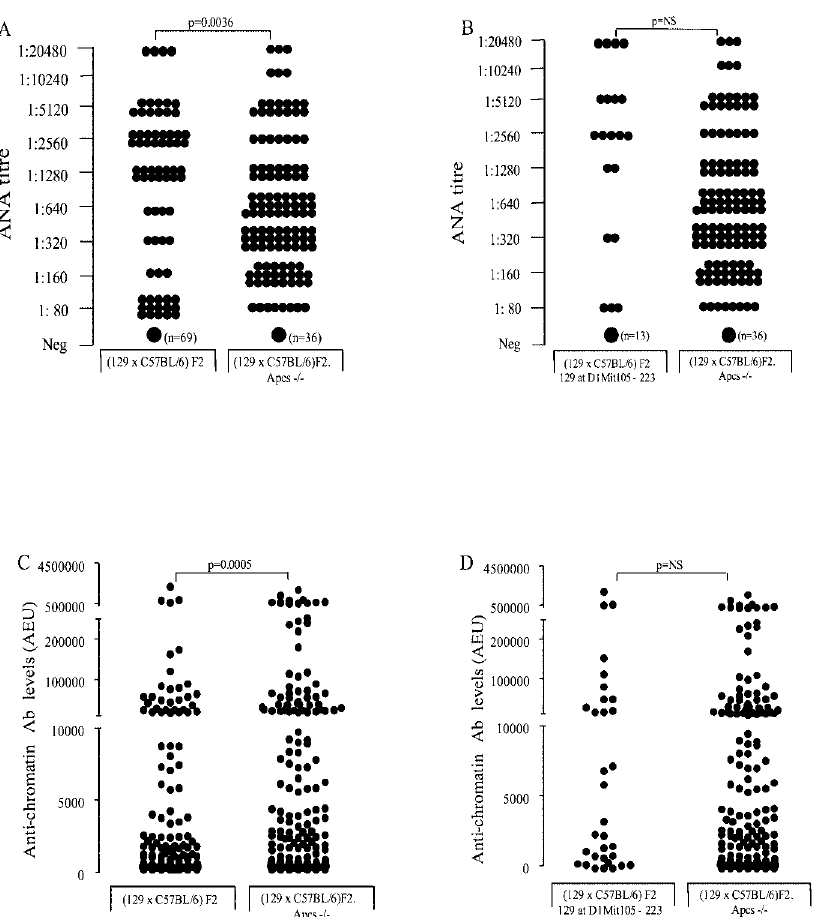
(A) ANA titres in the (129 3 C57BL/ 6)F2. Apcs (cid:1) / (cid:1) mice and (129 3 C57BL/6)F2 at 1 y of age. A small circle represents one mouse; a large circle, a variable number of animals, as indicated in parentheses. Serum samples were ti- trated to endpoint. (B) ANA titres in the (129 3 C57BL/ 6)F2. Apcs (cid:1) / (cid:1) mice and a selected number of wild-type (129 3 C57BL/6)F2 animals carrying the Chromosome 1 region between D1Mit105 and D1Mit223 (80– 106 cM) of 129 origin. The symbols are as in (A). (C and D) Anti-chromatin Ab levels expressed in AEUs related to a standard positive sample, which was assigned a value of 100 AEU. The comparison